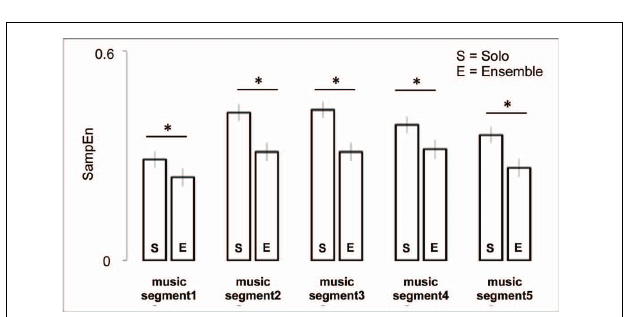
FIGURE 6 | Condition × music segment interaction effect. The histograms represent the amount of SampEn separately for each of the five music segments, for both conditions Solo (S) and Ensemble (E). In each sub-figure the lower bars represent significant comparisons. Asterisks denote significant